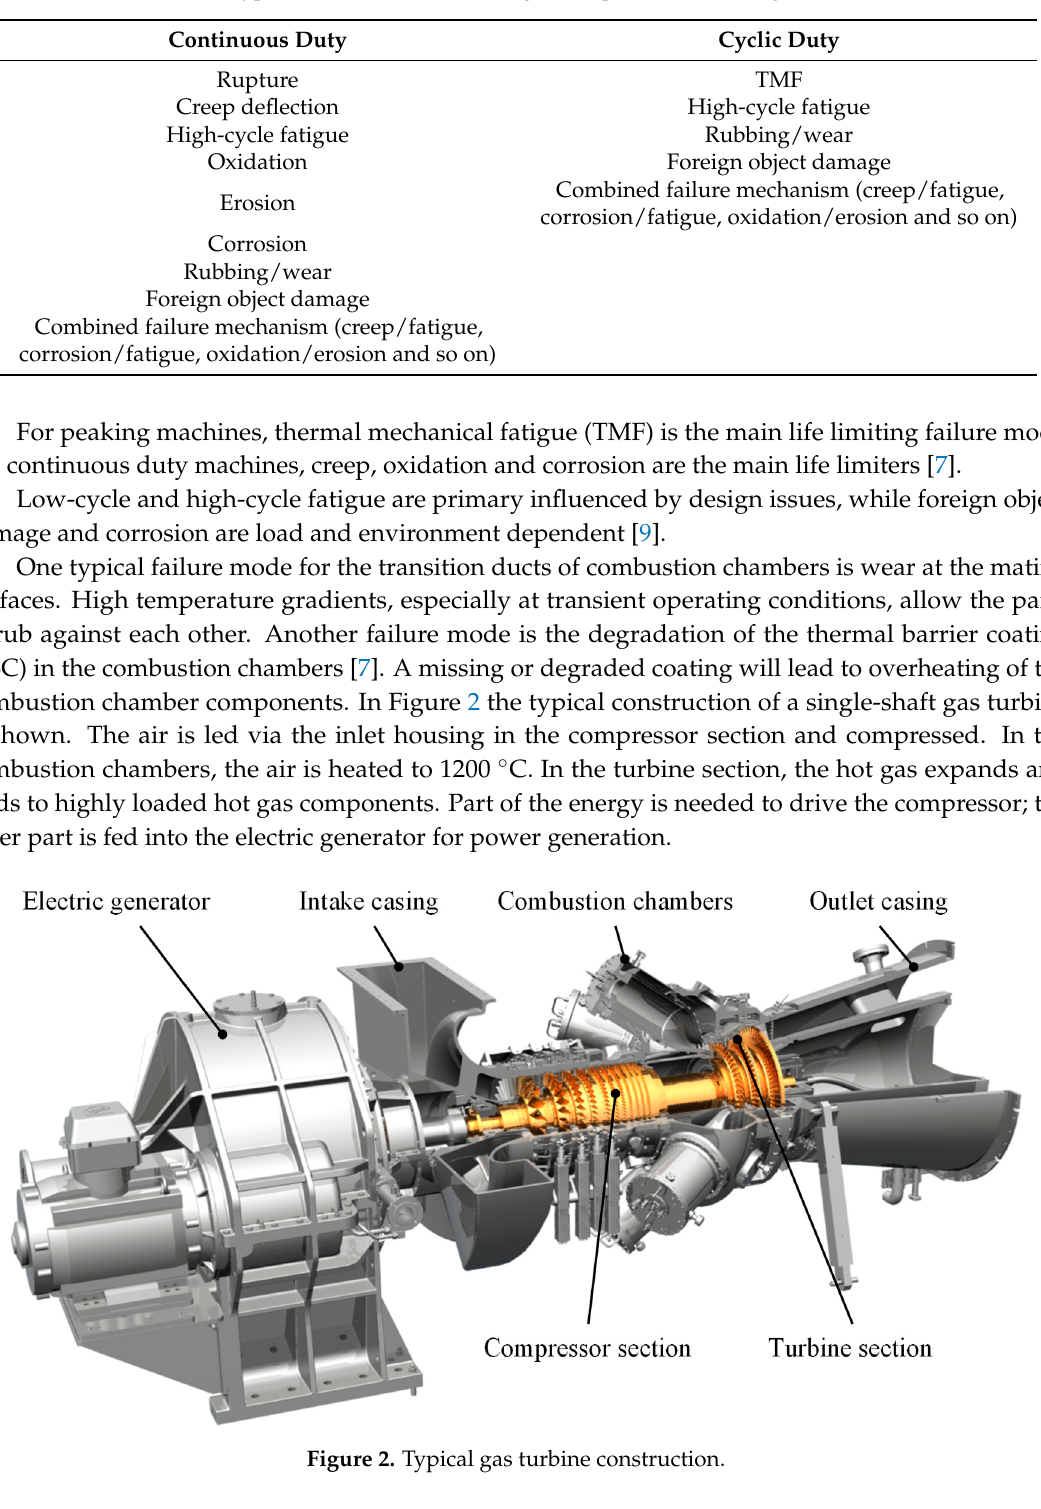
Table 1. Typical failure modes for hot gas components inside a gas turbine.